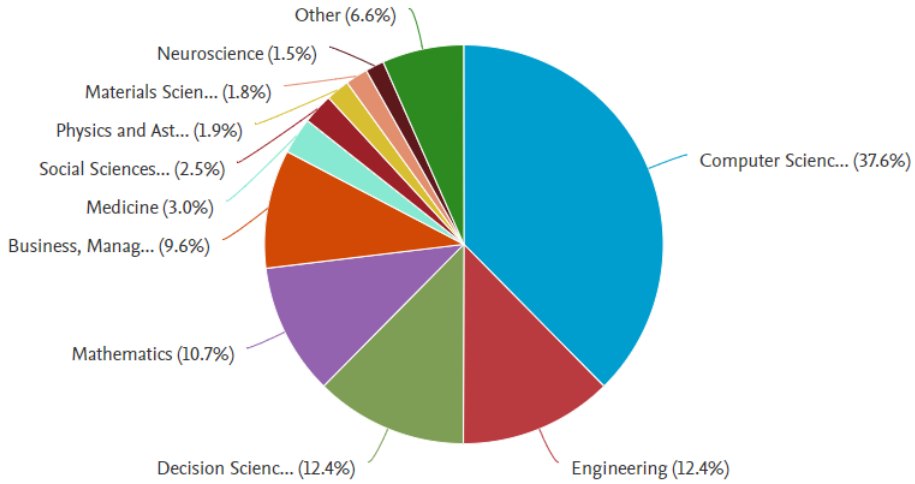
Figure 4. Documents by subject Area for “machine learning” AND “knowledge management” .